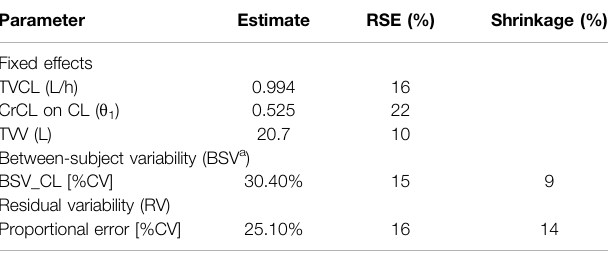
TABLE 3 | Population pharmacokinetic parameter estimates from the fi nal